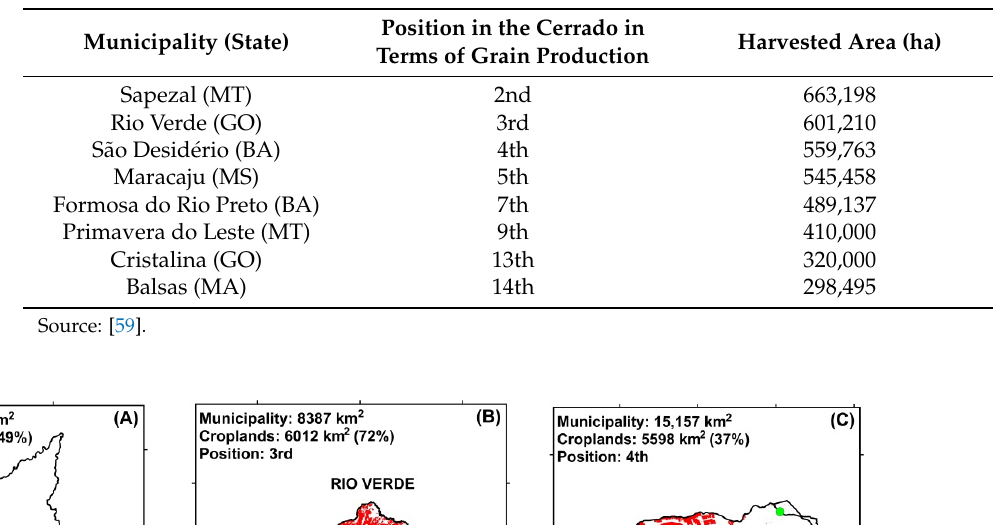
Table 5. Agricultural position and harvest area of soybean, corn, cotton, and sugarcane of chosen municipalities.